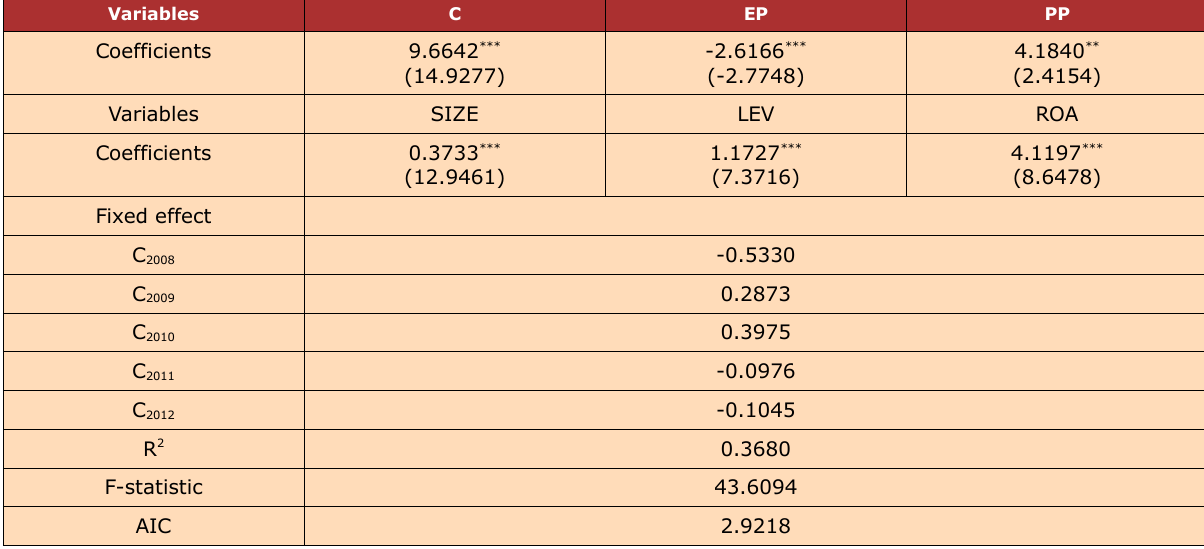
Table 6. Empirical results of the effect of environmental performance and propensity on financial